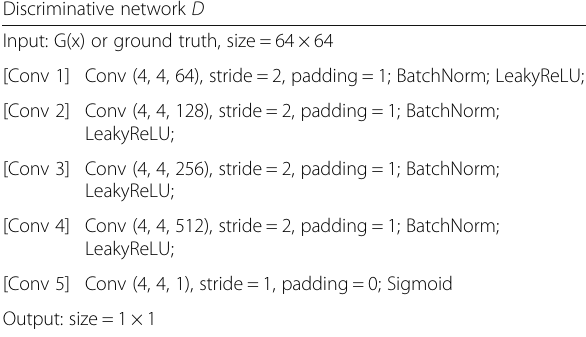
Table 2 The details of the discriminative network D